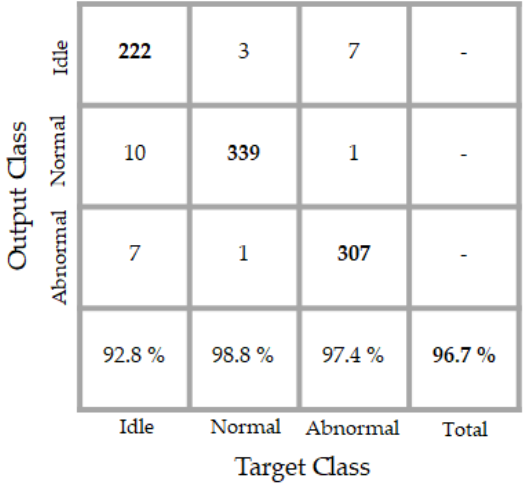
Figure 18. Confusion matrix of the classification results over the noisy test data. “Target class” denotes the labels and “output class” denotes the actual results of the network.